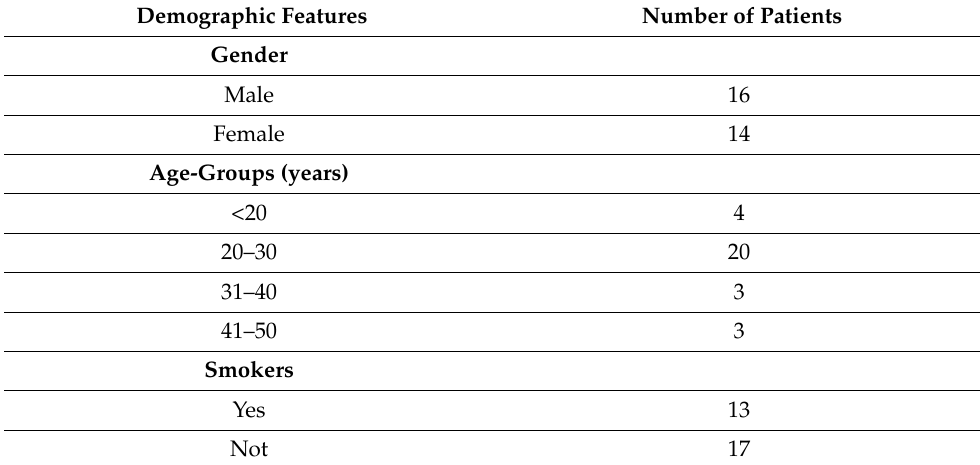
Table 1. Demographic features of the